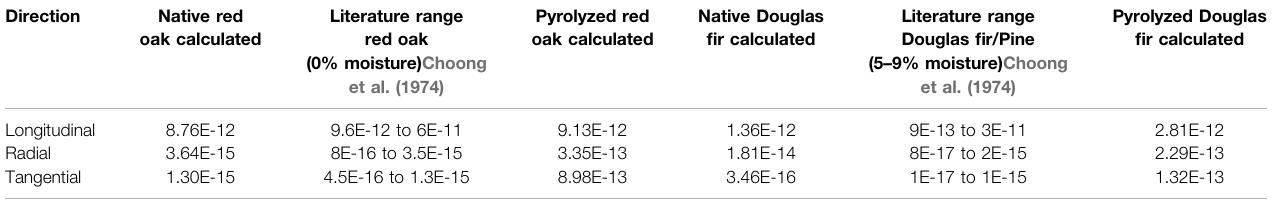
TABLE 2 | Calculated permeability tensors for each sample. All values in units of m 2 (i.e., m 3 · m/m 2 ). Direction